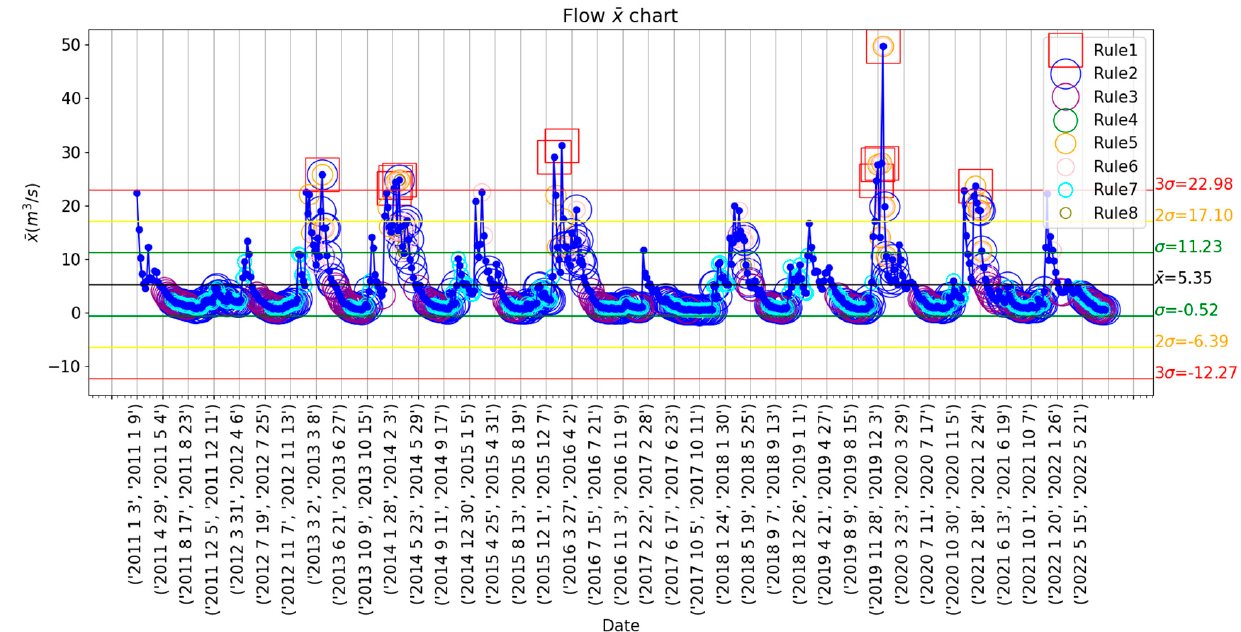
− Figure 3. Flow data is represented in the 𝑥̅ control chart with weekly rational subgroups and the Nelson rules implemented for outlier detection, trend study, and variability analysis. The mean of al subgroup is represented by a black line, while the green, yellow, and red lines mark the ± 1 σ , ± 2 σ , and ± 3 σ limits,